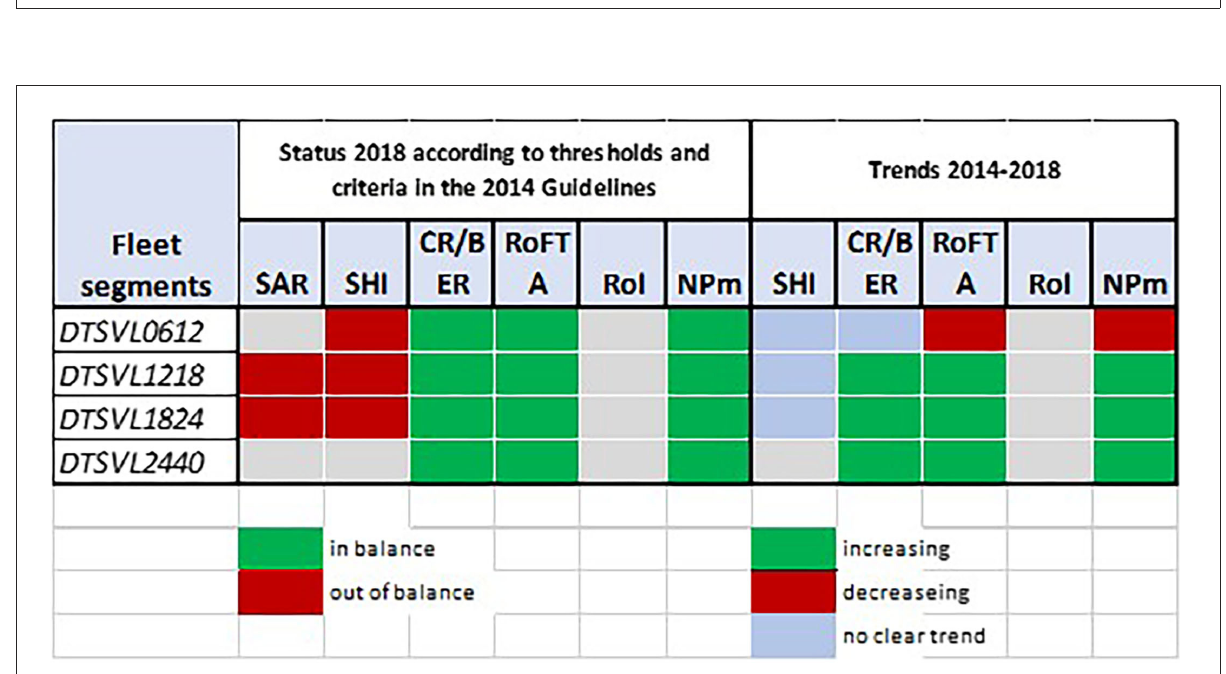
FIGURE7 Balance indicators for the Italian demersal trawl fleet in 2018 and the trend for the 2014–2018 period. Elaboration on data from STECF